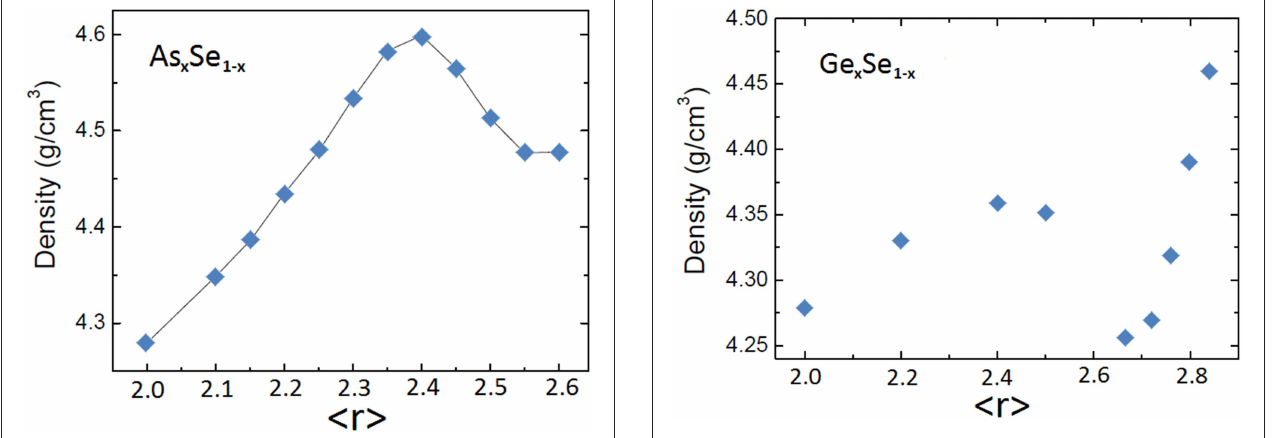
FIGURE 6 | Density of As-Se glasses as a function of average coordination < r > . Data from Yang et al. (2010).